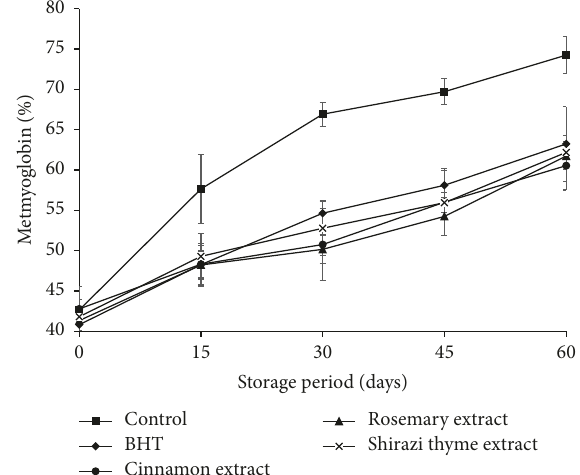
Figure 2: Effect of incorporating Shirazi thyme, cinnamon, and rosemary extracts on the metmyoglobin (%) developed in raw beef burgers during frozen storage at − 18 ∘